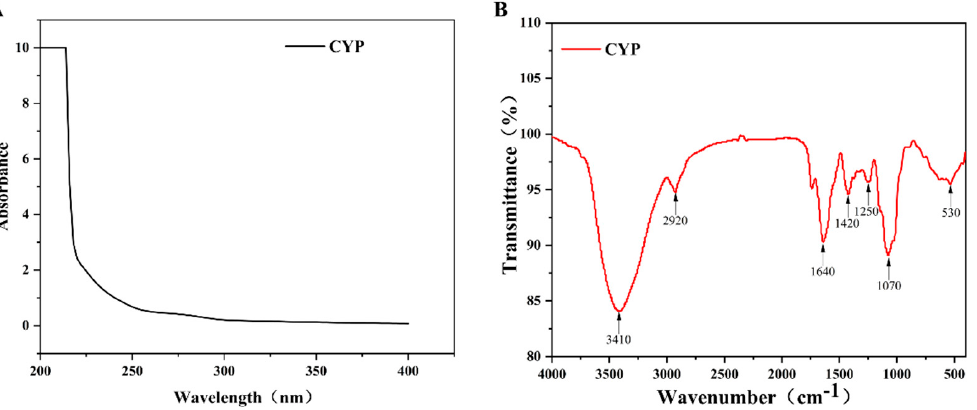
Figure 1. ( A ) UV − vis and FT − IR spectra of CYP ( B ) UV − vis spectra were recorded in the range of 200 − 400 nm. FT − IR spectra were recorded with a Nicolet 5700 FT − IR spectrometer between 400 and 4000 cm − 1 using the KBr − disk method.